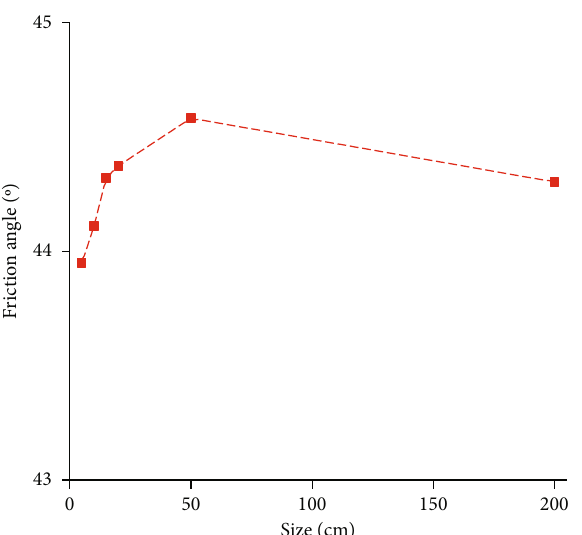
Figure 8: Relationship between the friction angle and model size.